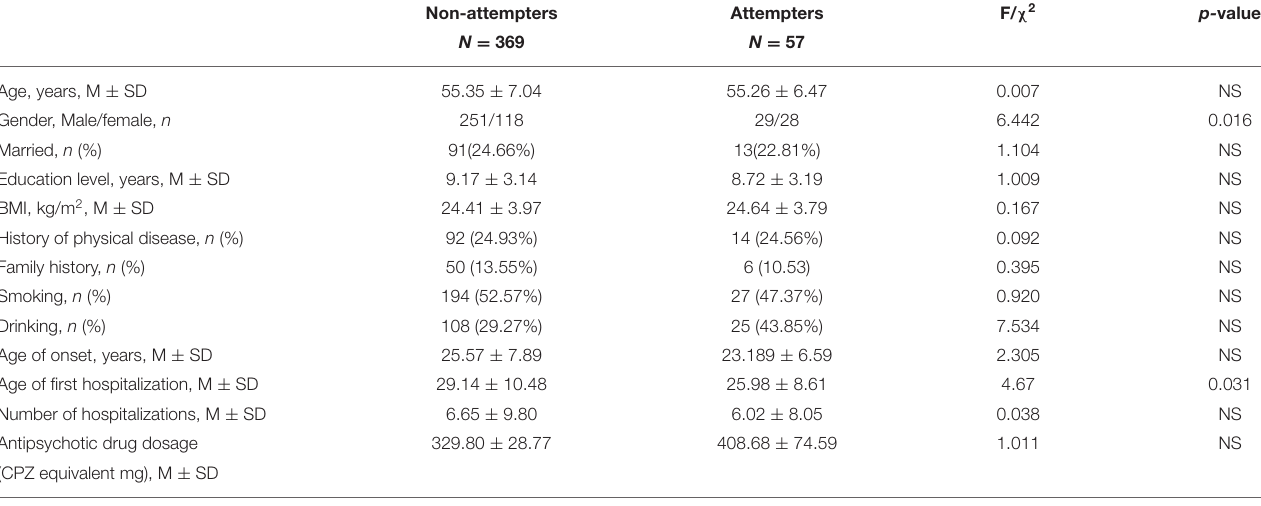
TABLE 1 | Demographic characteristics of attempter and non-attempter patients.